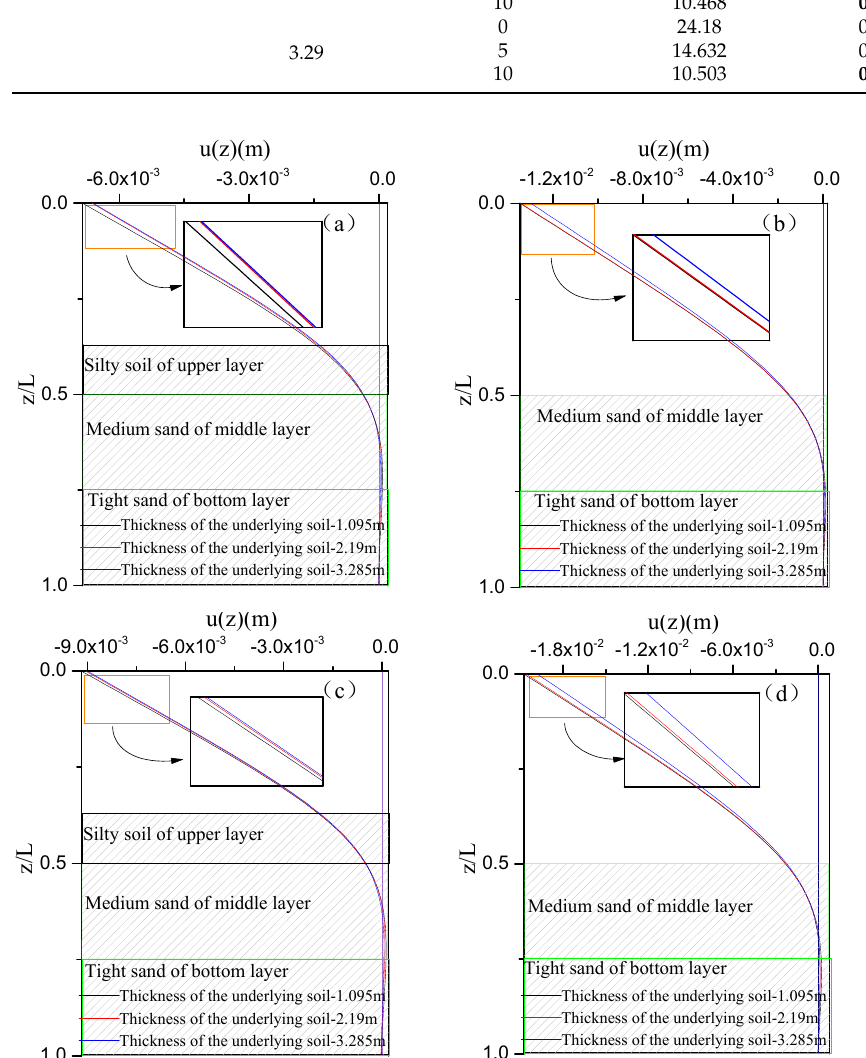
The variations of the mode shapes of the partially-embedded single pile under varied scour levels with the change of the thickness of the underlying soil are investigated in Figure 7. It is shown that the response amplitudes of the pile top of the single pile and the displacement amplitudes at the inverted point of the pile body decrease with the increase in the thickness of the underlying soil, regardless of the degree of scour.